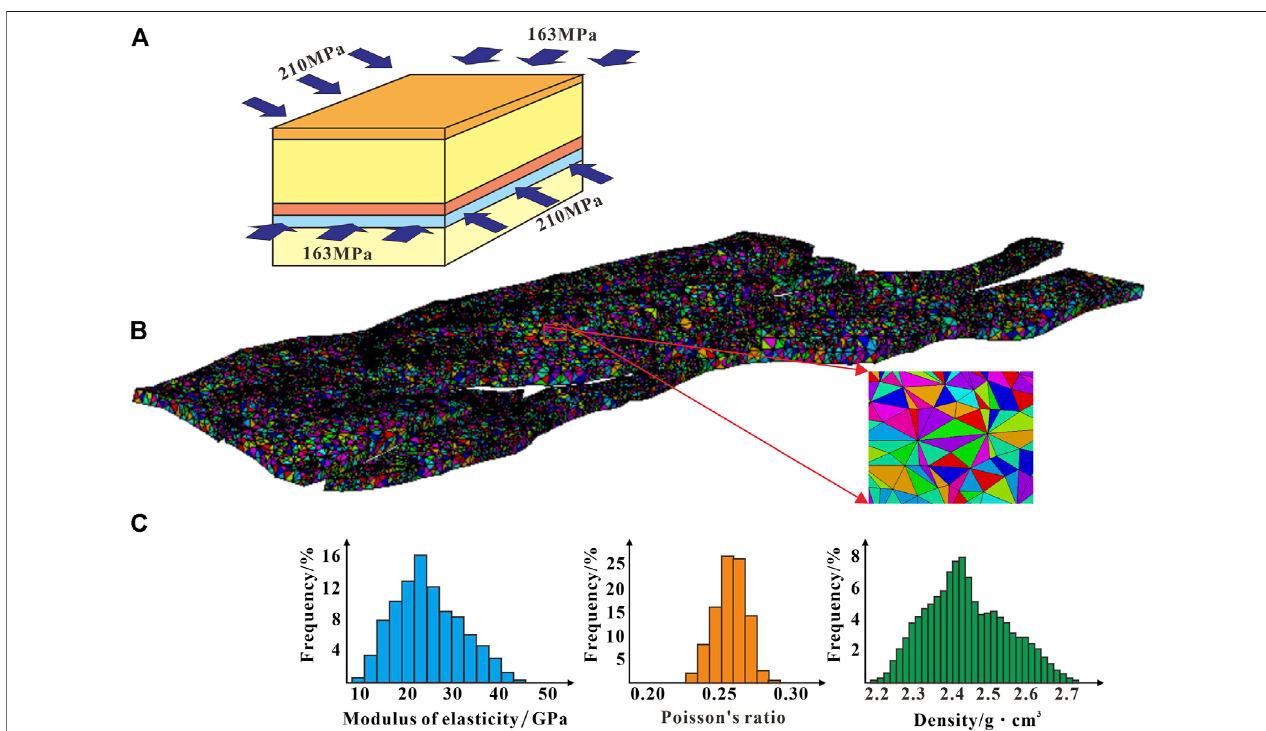
FIGURE 3 | (A) Outer frame established outside the Bozi gas fi eld model as the surrounding rock. The surrounding rock is divided into fi ve layers. A compression magnitude of 210 MPa is applied in the N – S direction and 163 MPa is applied in the E – W direction of the model; (B) Target layer model is assigned with 3D heterogeneous rock mechanical parameters, and the heterogeneous rock mechanical parameters are assigned to each grid of the fi nite element model. Each triangular grid represents a material, including an array comprising elastic modulus, Poisson ’ s ratio, density, and other parameters. Different colors represent different numbers of materials, and the grid color does not represent the distribution of rock mechanical parameters; (C) Distribution histogram of rock mechanical parameters.